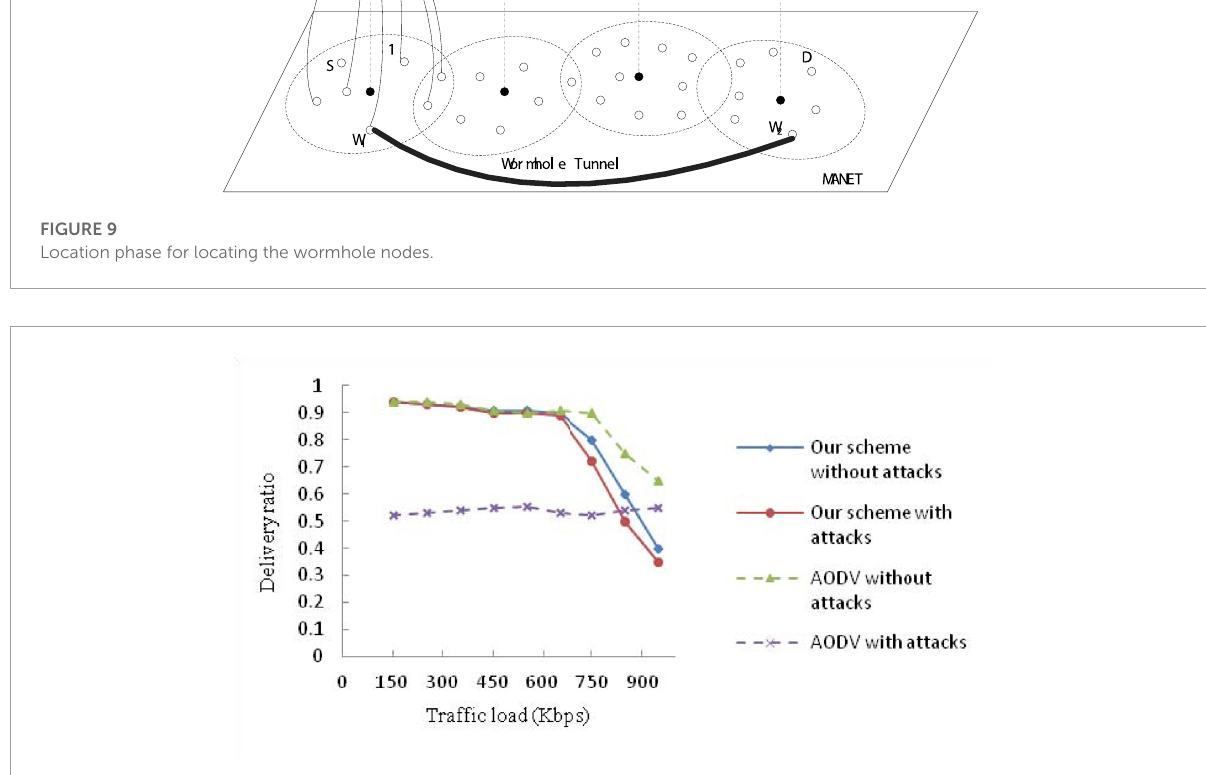
FIGURE 10 Packet delivery ratio vs traffic